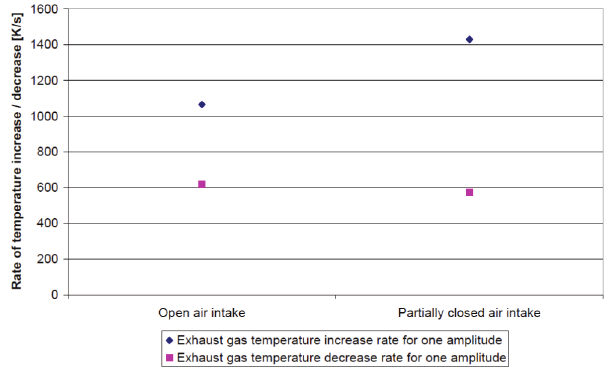
Fig. 7. Values of diagnostic parameters, such as the average rate of in- crease and decrease of exhaust gas temperature within one engine opera- ting cycle, depending on the technical condition of the intake air channel